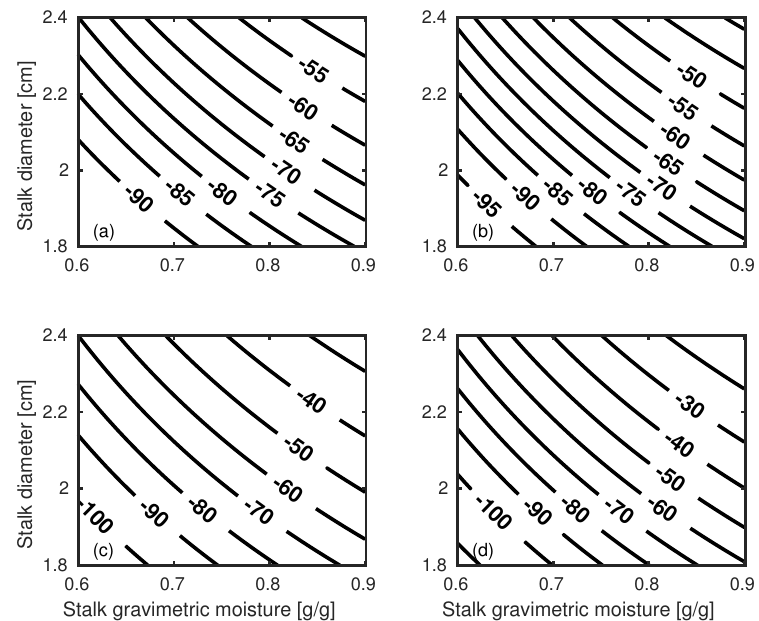
Figure 6. φ -contours resulting from the evaluation of (2) when coupling Mätzler’s model with Ulaby’s. Frequency is fixed at 1.25 GHz and incidence angle is 40°. Model parameters now include m g instead of ε st . Stalk height h is indicated. ( a ) h = 1.80 m. ( b ) h = 2.00 m. ( c ) h = 2.40